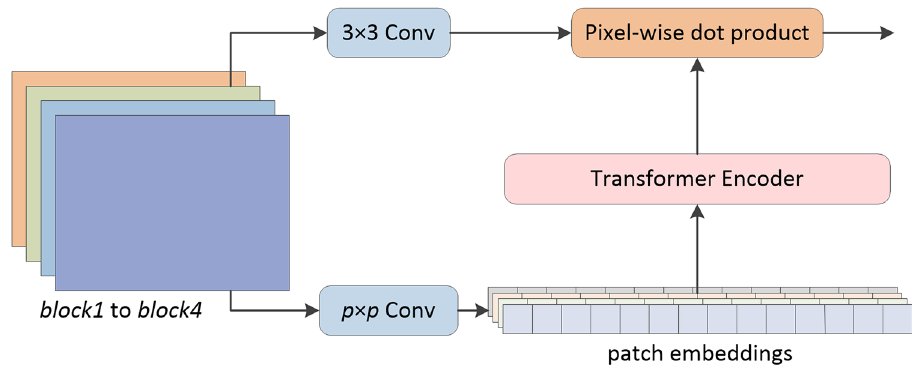
Figure 2. Structure of the fusion